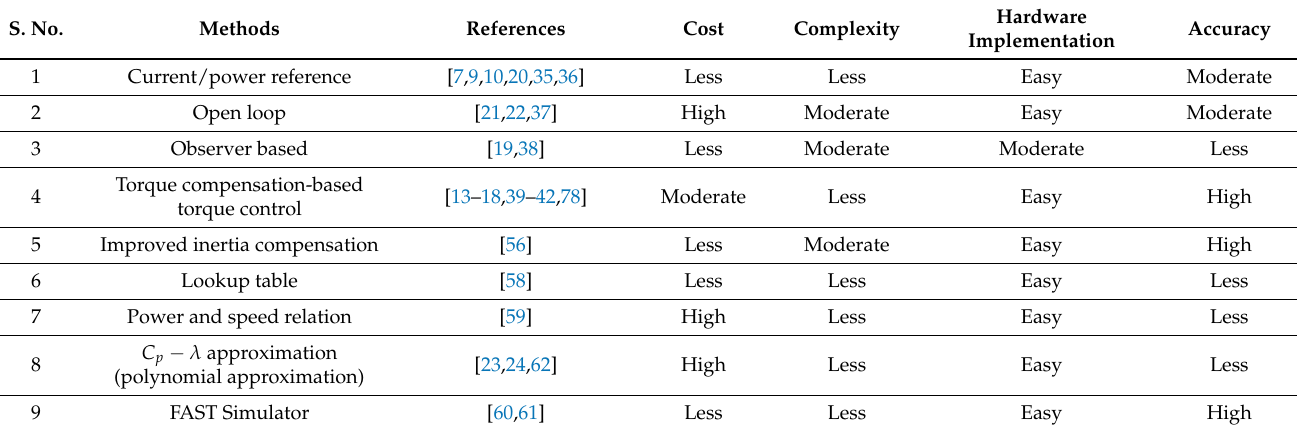
Table 4. Comparison of different methodologies of